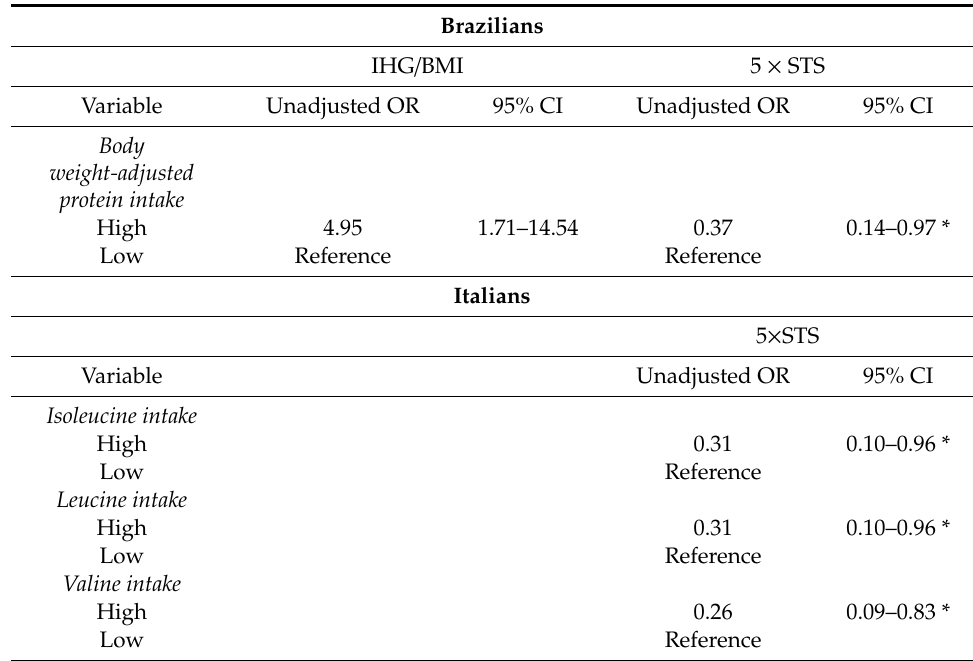
Table 3. Unadjusted odds ratios (ORs) and 95% confidence intervals (CIs) for physical function in Brazilian and Italian older